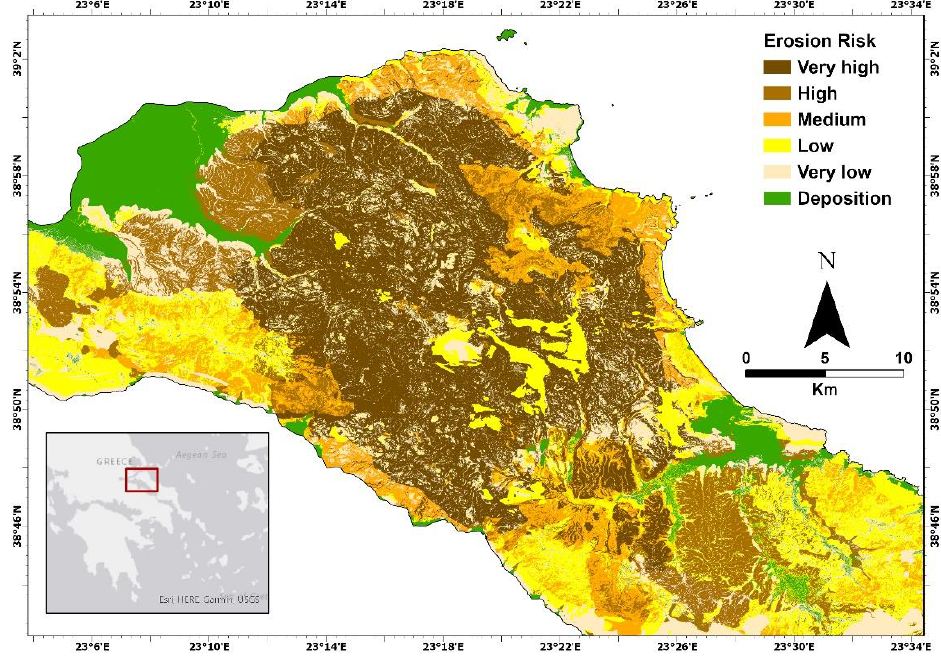
Figure 10. Results of erosion risk in the fire affected area of North Euboea using a Boolean logic- based model.